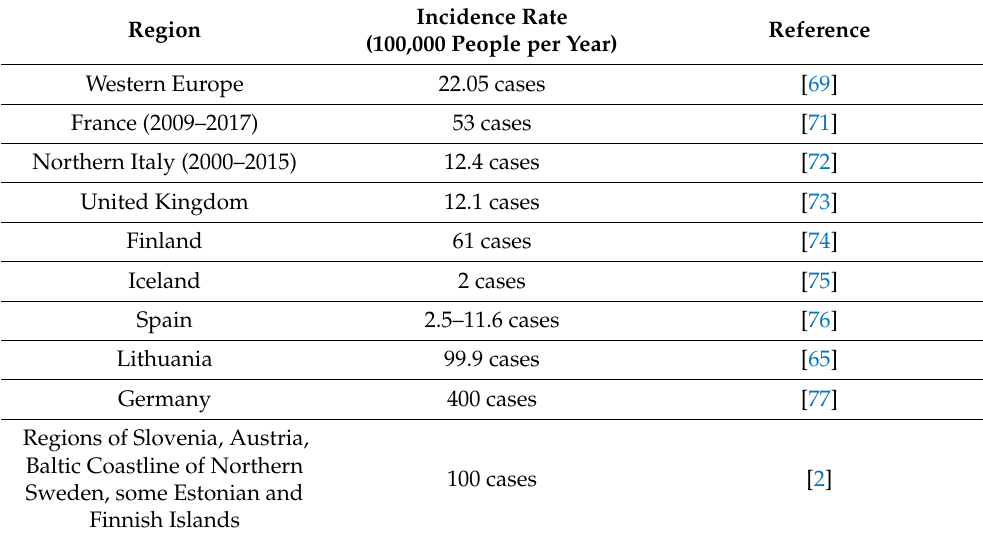
Table 2. Incidence rate for LB in